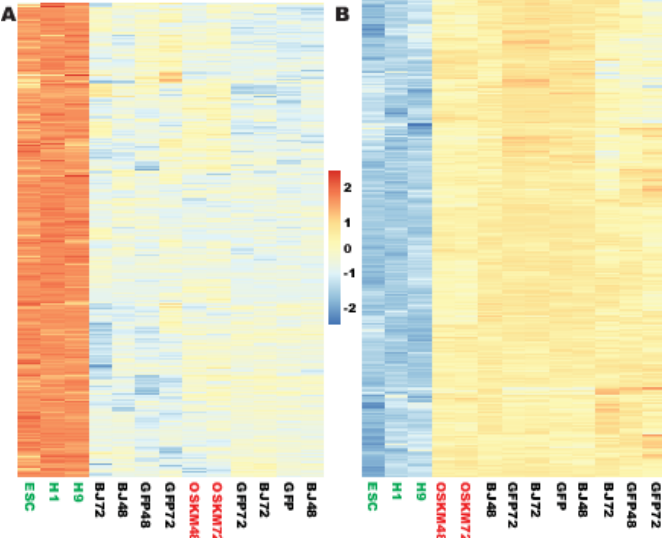
Figure 7. Two sets of cell-type-enriched, well-expressed genes were not responding to OSKM reprogramming at the early stage. ( A ) A heat map showing that 504 ESC-enriched genes were transcriptionally irresponsive to OSKM reprogramming at least before 72 h. ( B ) A heat map showing that 449 fibroblast-enriched genes were transcriptionally irresponsive to OSKM reprogramming at least before 72 h. Figure sample labels are the same as in Figure 1.